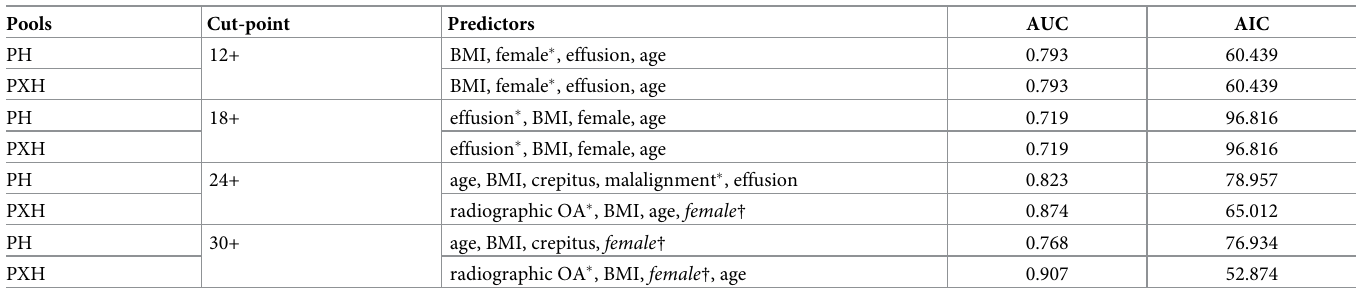
Table 5. Predictive utility measures for selected progression prediction models.